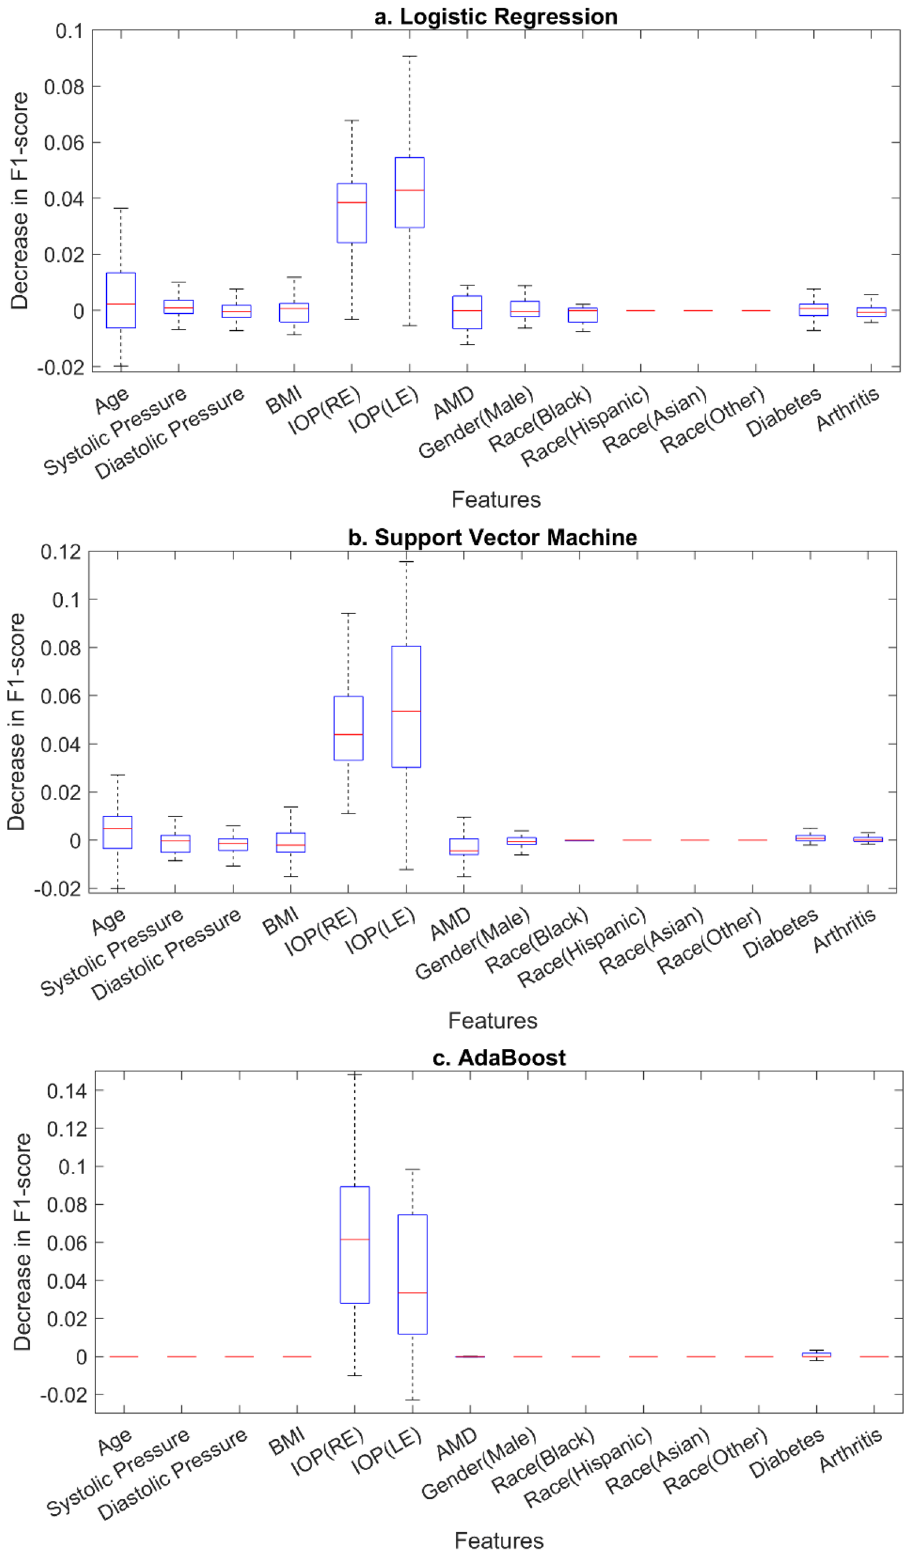
Figure 2. Permutation feature importance applied to each classifier: ( a ) Logistic regression, ( b ) Support vector machine, and ( c ) Adaptive boosting (AdaBoost). Mean decrease in F1 score is shown for each feature: age, systolic and diastolic blood pressure, gender (male), body mass index (BMI), intraocular pressure (IOP) in the right eye (RE) and left eye (LE), age-related macular degeneration (AMD) category, race (black, Hispanic, Asian, and other), and presence of diabetes and